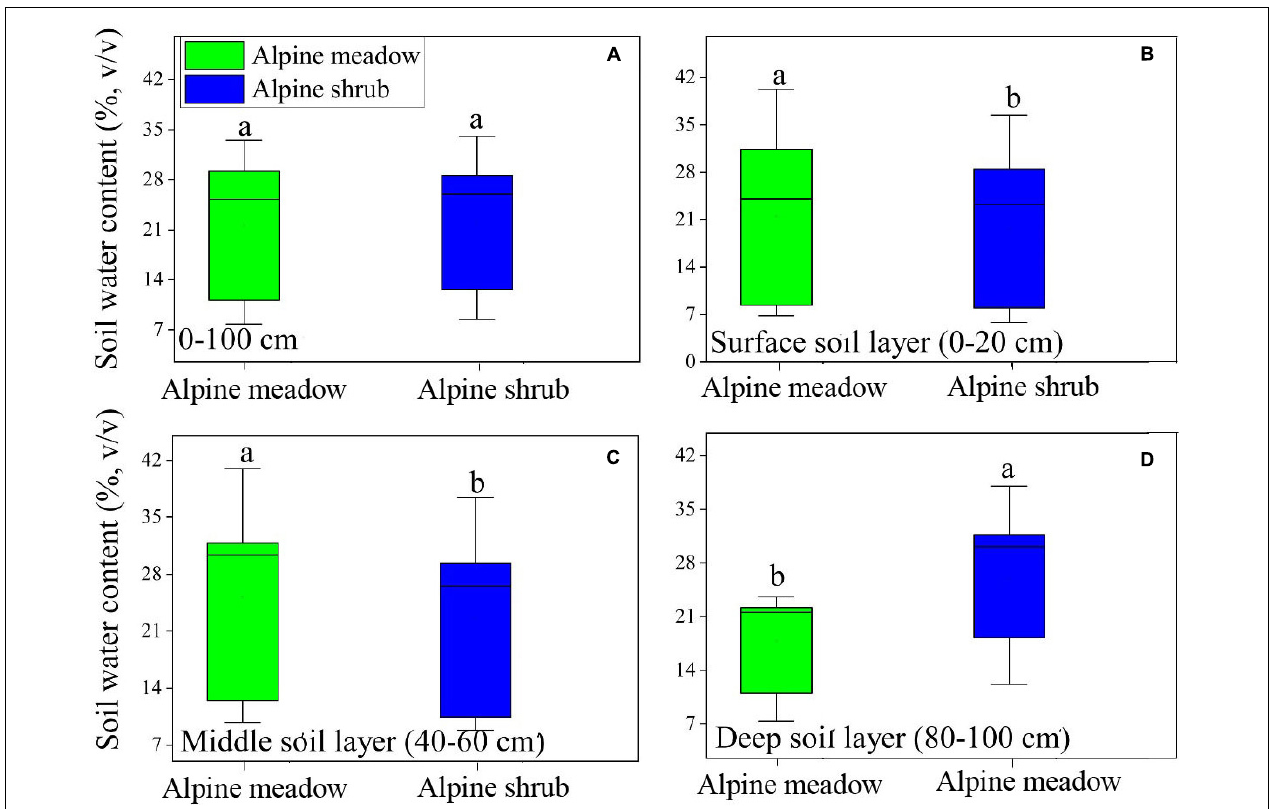
FIGURE 5 | Comparison of soil water content for 0–100 cm (A) , surface soil layer (B) , middle soil layer (C) , and deep soil layer (D) across two vegetation types.